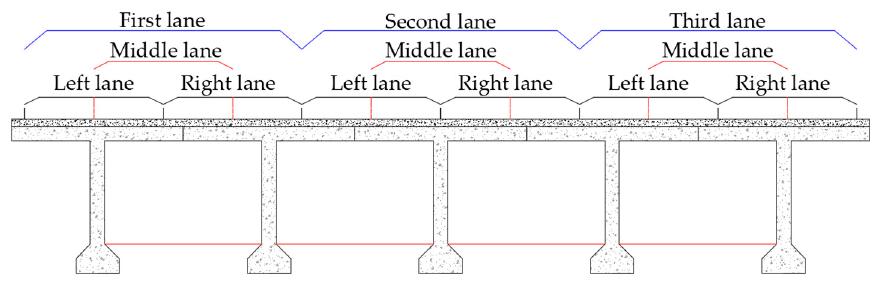
where, P 11 and P 12 represented the front wheel loads, P 21 and P 22 represented the rear wheel loads, P was the total weight of the vehicle. The vehicle wheelbase was 300 mm, the wheel-track was 180 mm, and the vehicle speed was 1 m/s, as shown in Figure 5c. The vehicle load P was divided into three grades, 10 kg, 20 kg, and 30 kg, respectively. The load grade of 10 kg was used to calibrate the strain integral coefficient, and the other load grades were used to test. As shown in Figure 6, the bridge model was divided into three lanes, and the vehicle acted on the left, middle, and right positions of each lane. Thus, the vehicle load position was divided into nine conditions. Figure 6. Vehicle load